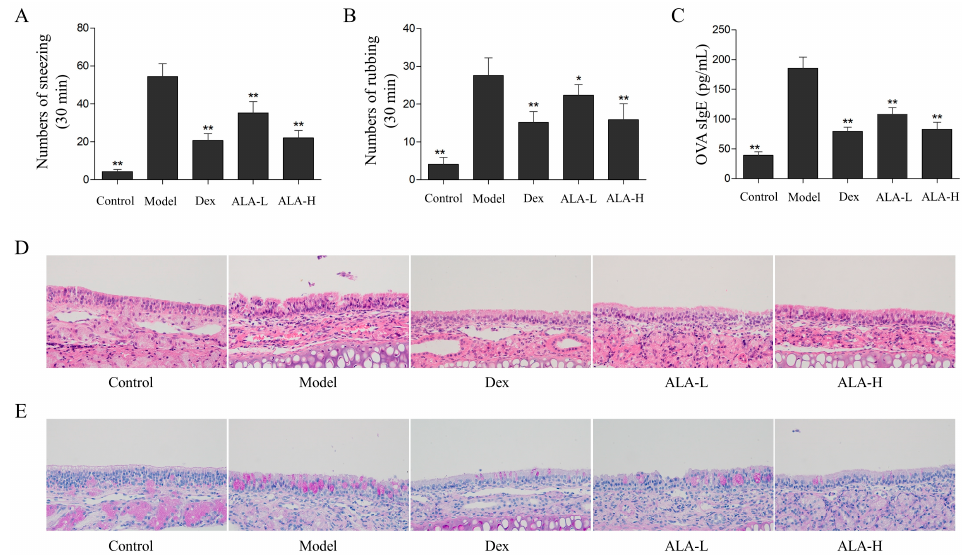
Figure 2. Effect of ALA on OVA-induced AR in mice. The numbers of sneezing ( A ) and rubbing actions ( B ) of mice were counted for 30 min immediately after the last intranasal challenge. ( C ) The level of OVA-sIgE in serum were measured by enzyme-linked immunosorbent assay (ELISA). The HE ( D ) and PAS ( E ) staining were used to observe the histopathological changes in nasal mucosa samples of mice. Between-group comparisons were performed using one-way ANOVA coupled with LSD t -test (equal variances assumed) or Tamhane’s T2 test (equal variances not assumed). Data are expressed as mean ± SD; n = 10; * p < 0.05, ** p < 0.01 versus AR model. Dex, dexamethasone; ALA-L, low dose of α -linolenic acid; ALA-H, high dose of α -linolenic acid.